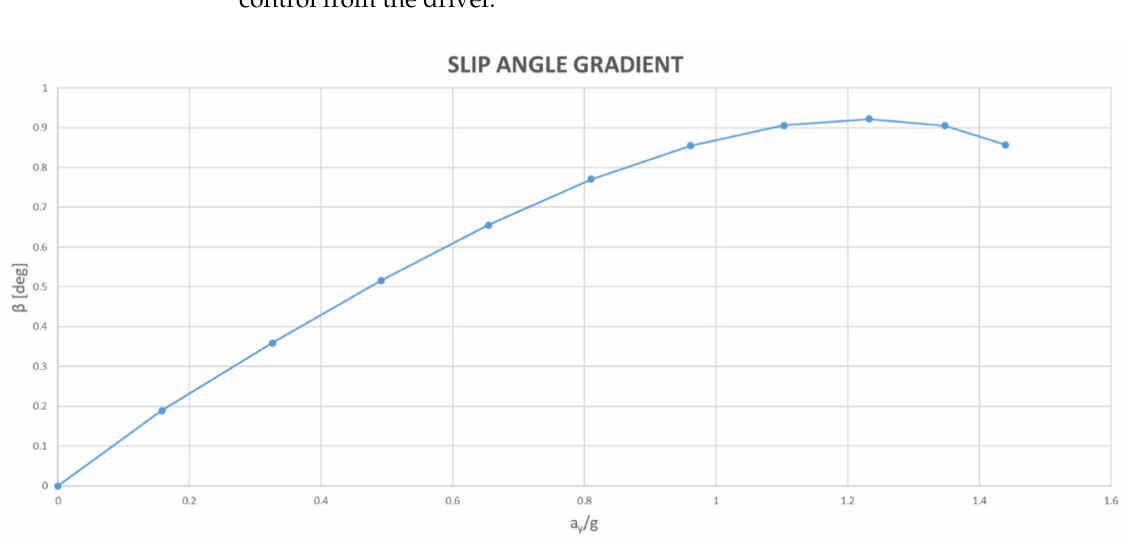
Figure 7. Slip angle